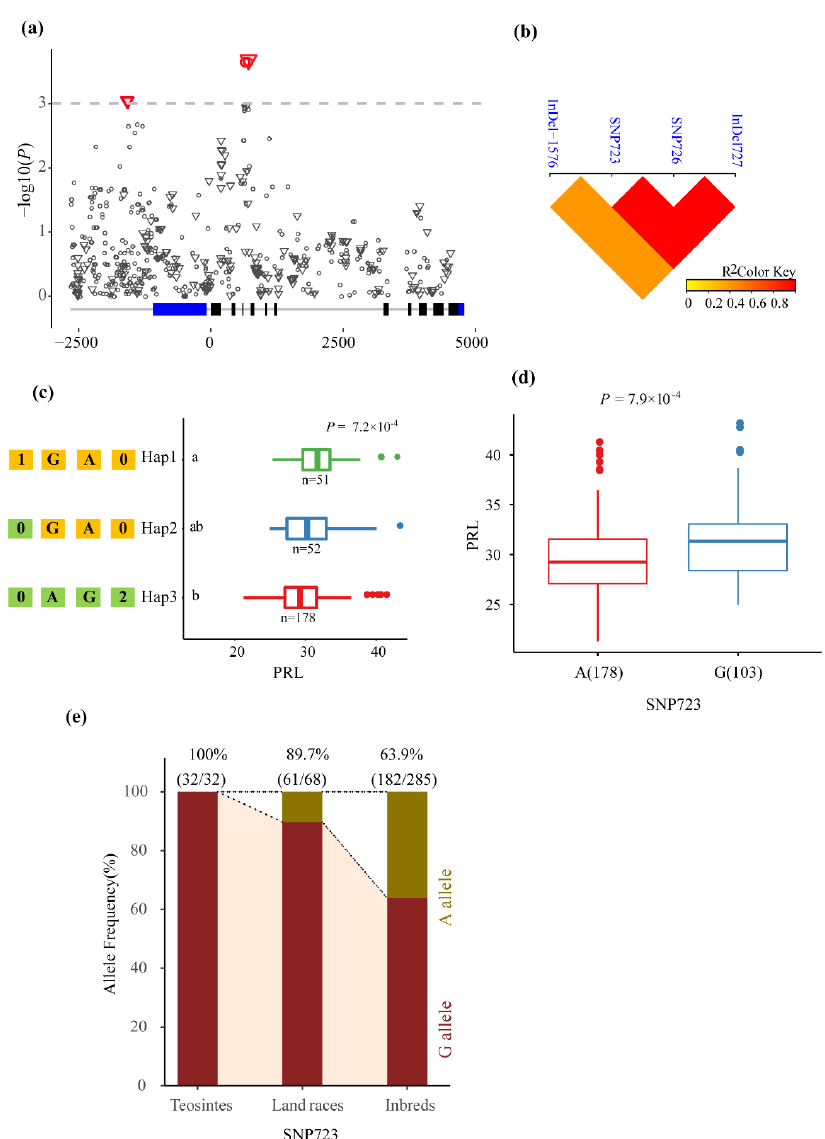
Figure 3. Natural variations in ZmMADS60 were significantly associated with primary root length (PRL). ( a ) ZmMADS60 -based association mapping for PRL, A schematic diagram of the genomic region of ZmMADS60 , including upstream sequence and introns ( light gray ), the coding region ( black ), and 5'UTR and 3'UTR ( blue ) is presented. ( b ) Linkage disequilibrium (LD) heatmap for four significant variants associated with PRL. ( c ) Haplotypes of ZmMADS60 among natural variations in inbred lines. ( d ) Comparison of primary root length between different alleles of SNP723. ( e ) The allele frequency of SNP723 in teosinte, landrace, and inbred lines.